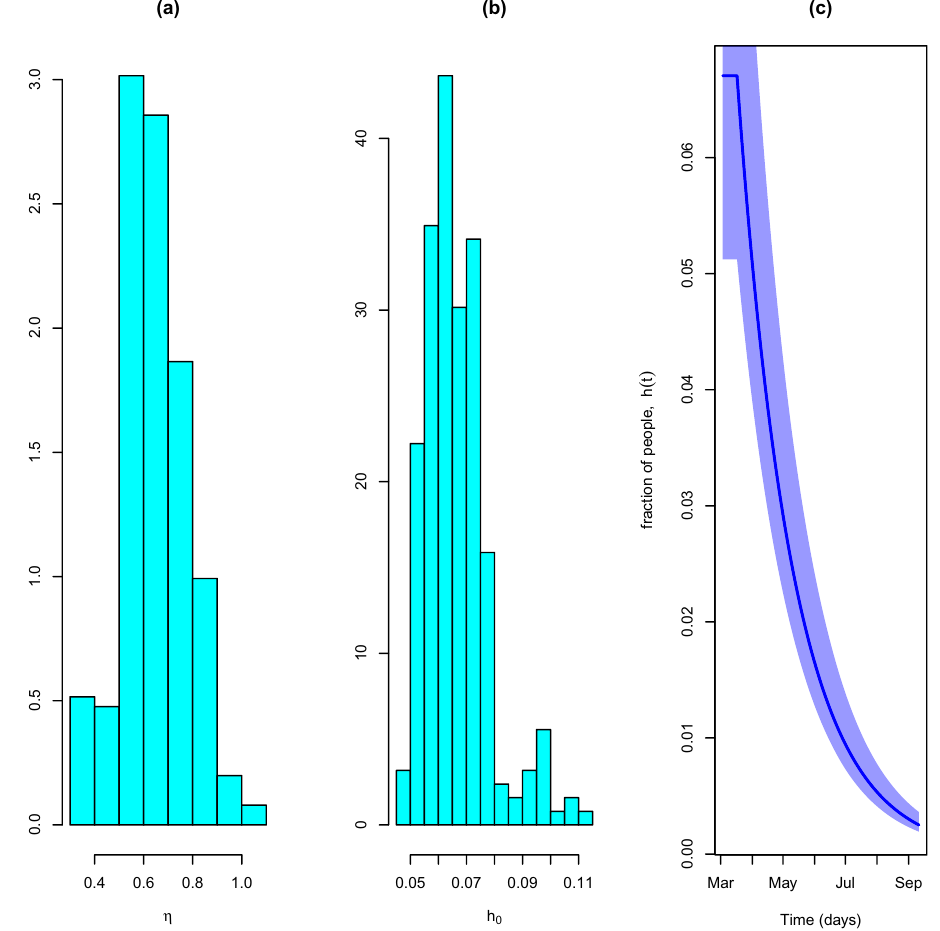
Figure 11. Hospitalisation rate. ( a ) Hospitalisation rate distribution, η . ( b ) Initial hospitalisation fraction, h 0 . ( c ) Hospitalisation fraction course, h ( t